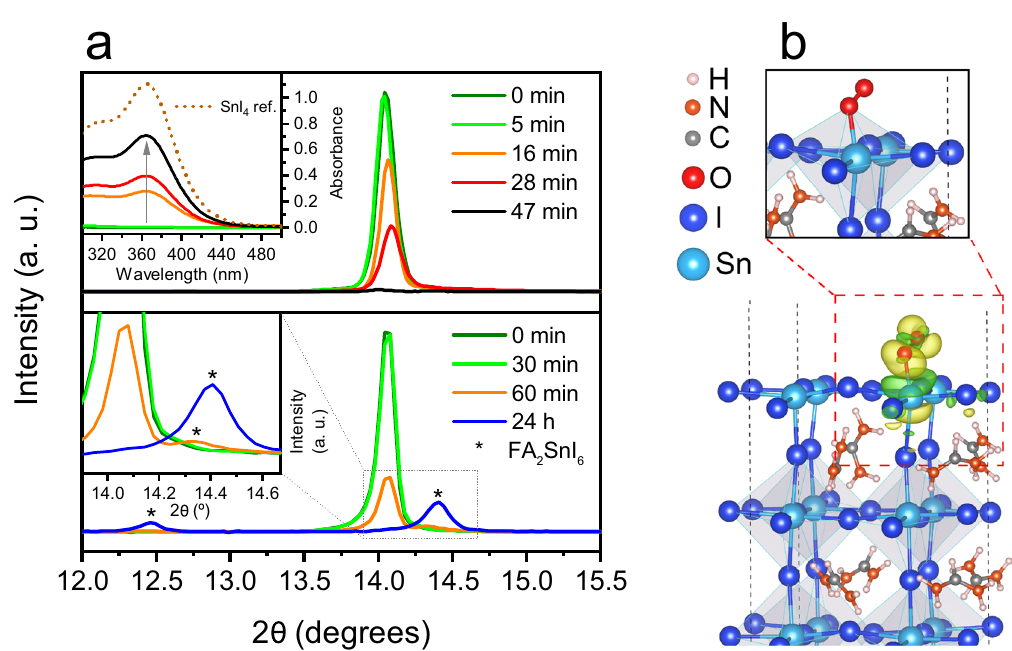
Fig. 2 Degradation of Sn perovskite under ambient air. a Time evolution of the (100) XRD re fl ection of (PEA) 0.2 (FA) 0.8 SnI 3 fi lms exposed to ambient air at 100 °C (top; inset: absorbance spectra of SnI 4 dissolved in 3 mL of toluene after its sublimation from the heated fi lm and capture in a Petri dish during different times) and room temperature (bottom; inset: magni fi cation of peaks corresponding to 60 min and 24 h). Peaks labelled with * correspond to FA 2 SnI 6 . b Adsorption of an O 2 molecule on a (001) surface of FASnI 3 perovskite and charge density difference, which highlights bond formation between O and Sn atoms (from DFT simulations). Yellow and green charge densities refer to electron accumulation and depletion respectively (with an isosurface value of 0.006 Å − 3